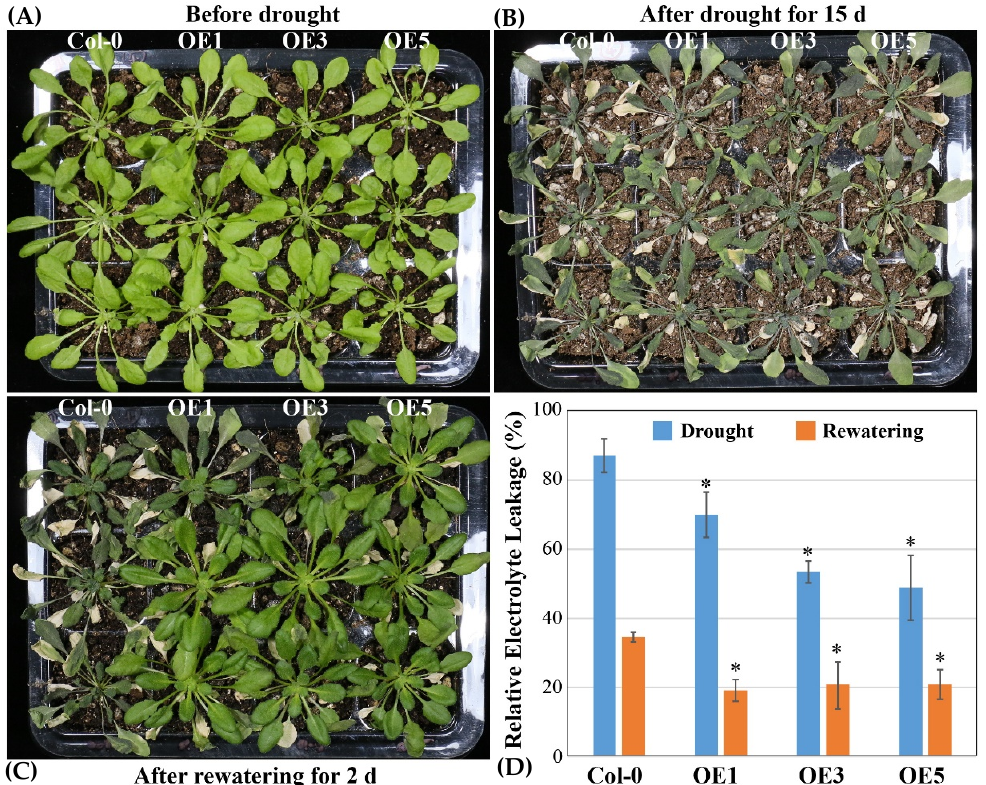
Figure 8. Overexpression of CsATG18a enhanced drought tolerance in transgenic Arabidopsis. ( A–C ) The representative pictures of three homozygous OE lines (OE1, OE3, and OE5) of CsATG18a and WT (Col-0) of Arabidopsis that were treated before drought ( A ), after drought for 15 days ( B ), and after rewatering for 2 days ( C ). ( D ) Relative electrolyte leakage of WT and OE lines measured after drought for 15 days and after rewatering for 2 days.